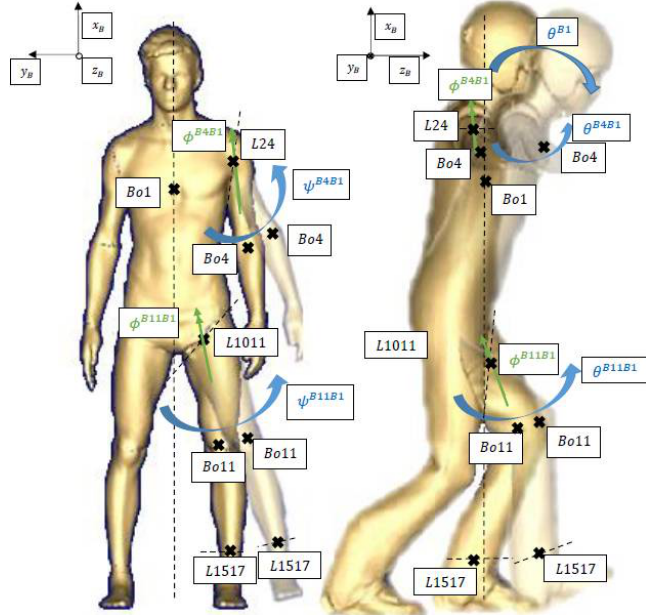
Figure 1. MBS model of ski jumper with several bodies and movement directions.